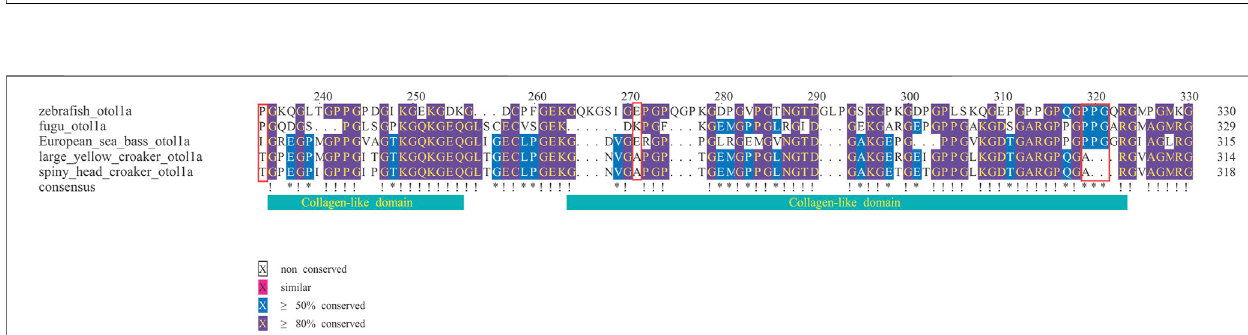
Frontiers in Genetics |